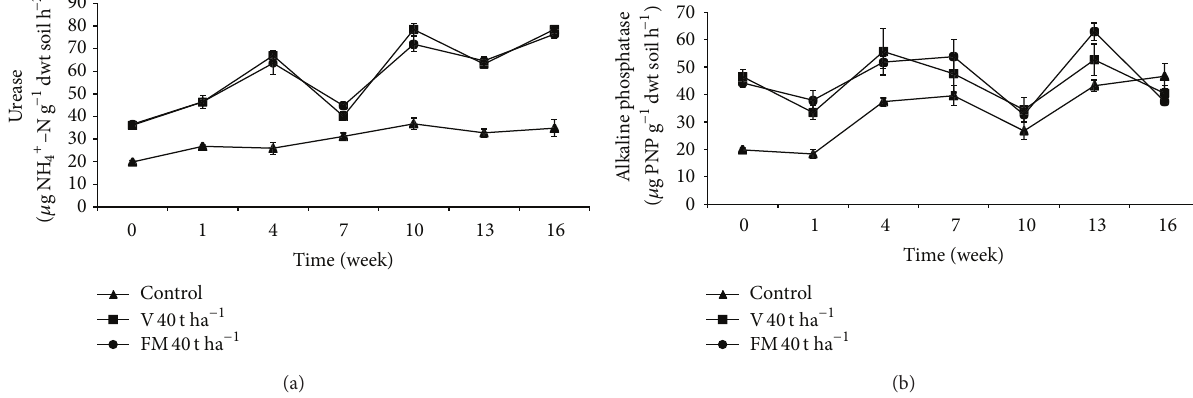
Figure 3: Changes in urease (a) and alkaline phosphatase (b) activity in soils treated with vermicompost (V) and farmyard manure (FM) at the rate of 40 tha −1 . Error bars represent standard errors based on four replicates.